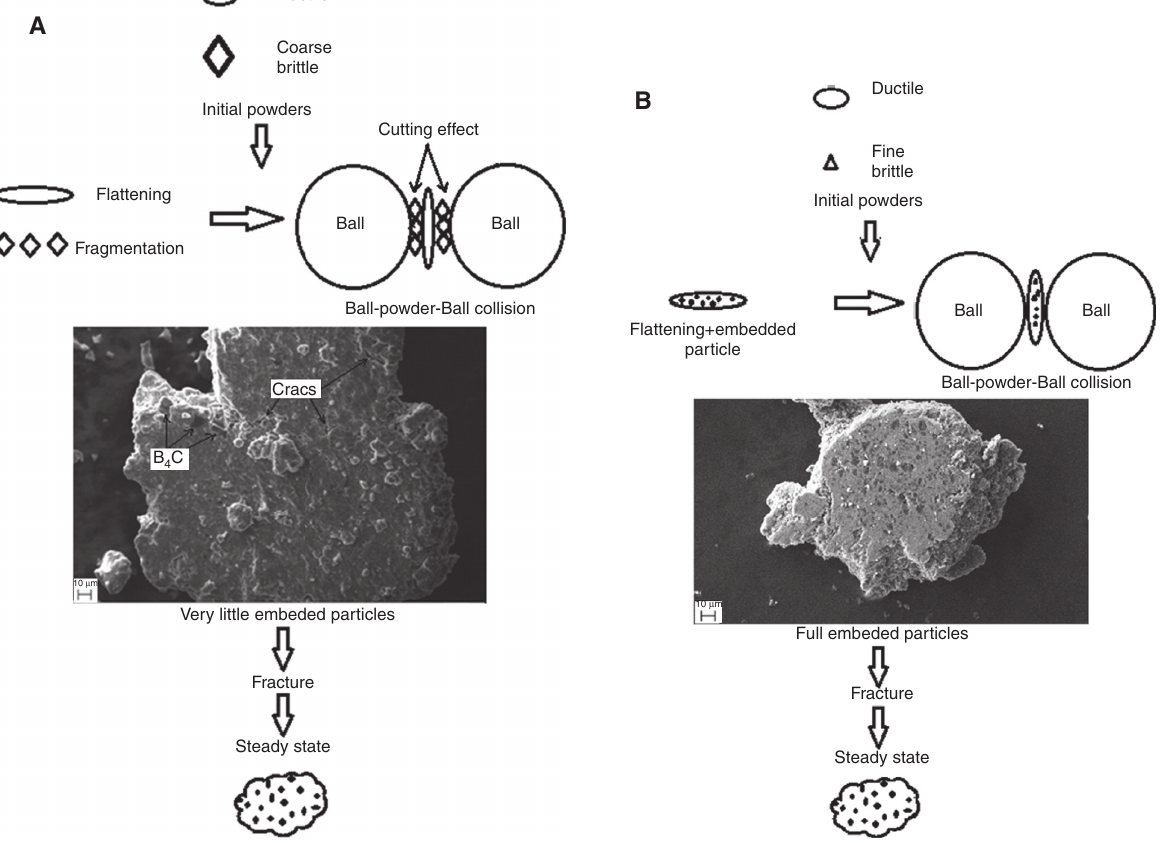
Figure 6 The milling models showing the effect of reinforcement size on the milling process: (A) coarse brittle powders, (B) fine brittle powders.